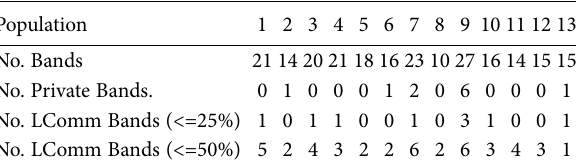
Table 4. Details of ISSR bands obtained in the studied populations of Ziziphus jujuba (populations numbers are according to Table